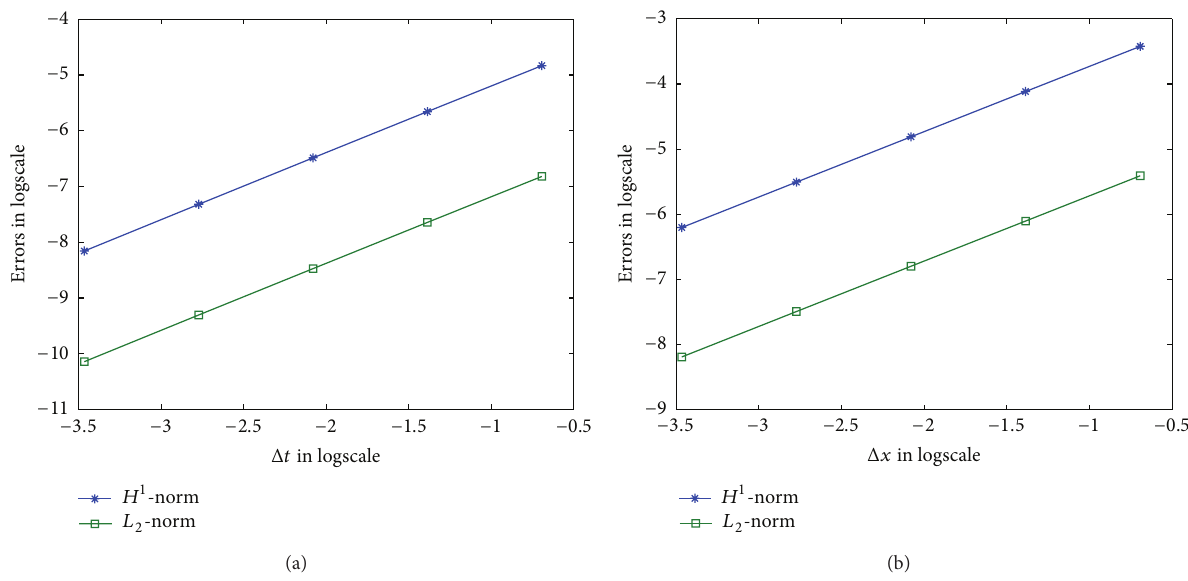
Figure 4: 𝐻 1 -norm and 𝐿 2 -norm of errors for Example 3; here, Δ𝑥 = 0.001 (a) and Δ𝑡 = 0.001 (b).